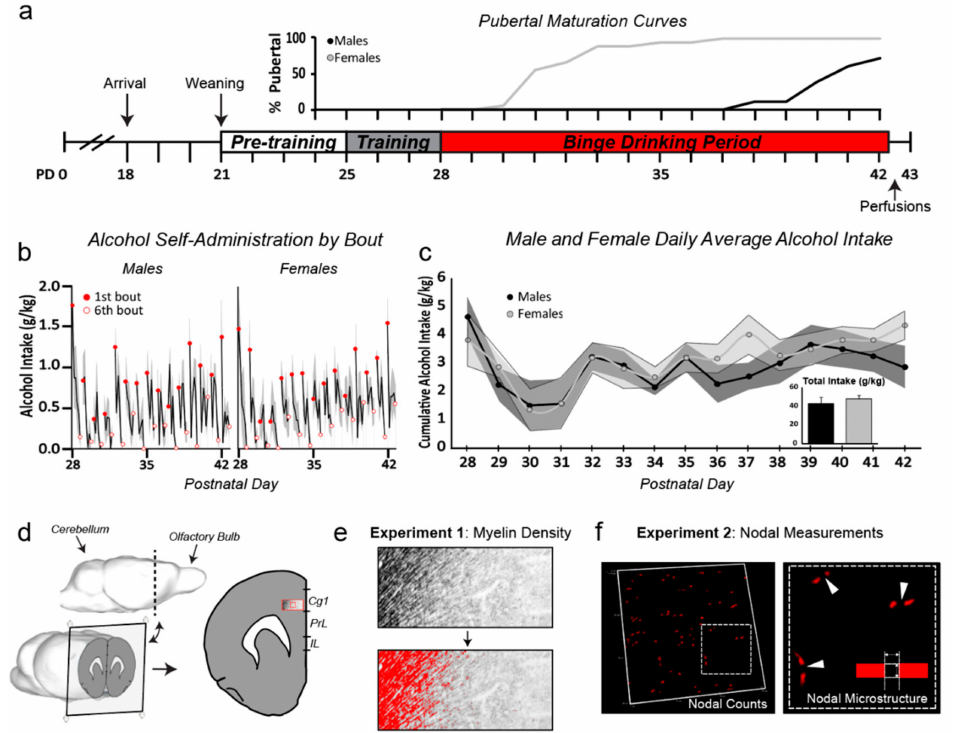
Figure 1. Overview of experimental design, pubertal maturation, and alcohol self-administration. ( a ) Timeline of operant self-administration and pubertal maturation curves (indexed by external signs of pubertal onset). Females were in a pre-pubertal state for a few days to one week after alcohol exposure began, whereas males were pre-pubertal for most of the two-week exposure period (sex di ff erence in pubertal maturation, p < 0.0001; no e ff ect of treatment, p > 0.05). ( b ) Alcohol intake (g / kg) within each self-administration bout. Animals had access to sweetened solution (alcohol or water) for 30 minutes for each bout, followed by 60-minute breaks where the lever was retracted (6 bouts / day for two weeks). Both males and females showed evidence of ‘front-loading’ within an overnight session, drinking significantly more during the first bout of each day when compared to the last bout ( p < 0.01 for both males and females). ( c ) Average g / kg daily alcohol intake (line graph, with shaded SEMs) and total g / kg alcohol intake (bar graph inset) did not di ff er with sex ( p > 0.05). ( d ) Three-dimensional model of a rat brain (adapted from [23], and edited using the Sketchup 3D modeling computer program (Trimble Inc., Sunnyvale, CA, USA)) showing the location of the sections taken for analyses in both experiments (2.2 mm anterior to Bregma). The large red box outlining the Cg1 represents the location in which samples were taken for Experiment 1 (myelinated fiber density, layers II-V, ( e ), while the smaller red box represents the location from which images were taken for Experiment 2 (nodal measurements, layer II / III, ( f ). Abbreviations: Cg1, anterior cingulate cortex, PrL, prelimbic cortex, IL, infralimbic, SEMs, standard errors of the